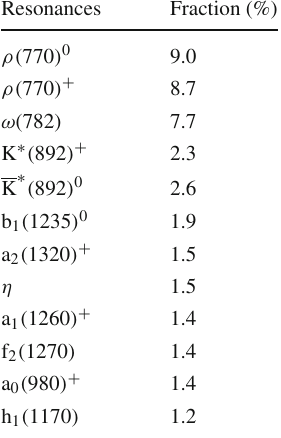
which contribute at least 1% to the yield of π + . The fractions are computed with Thermal- FIST for pp minimum bias collisions at √ s = 13 TeV, and used also for the other collision systems